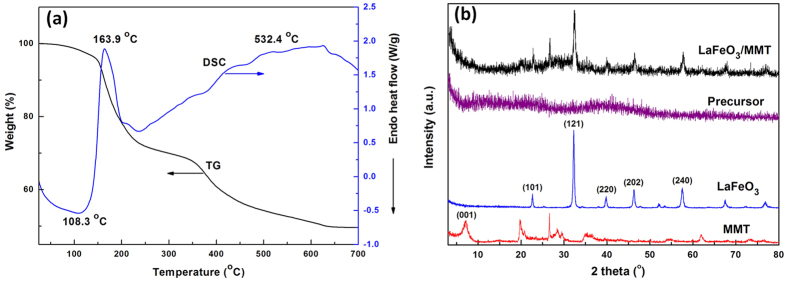
Formation and phase structure of the samples.(a) TG-DSC curves of LaFeO3/MMT precursor and (b) XRD patterns of MMT, LaFeO3, precursor and LaFeO3/MMT.